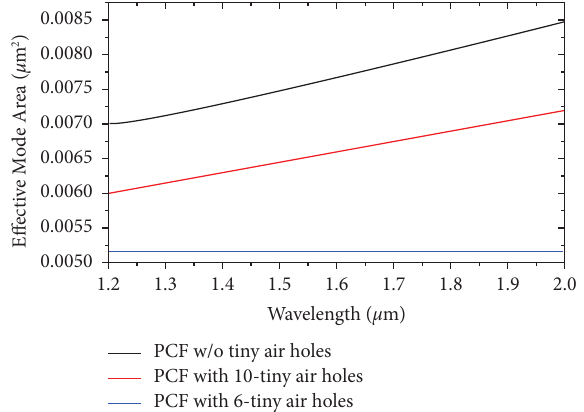
Figure 13: Variation of the efective mode area as a function of wavelength for the diferent PCF structures.